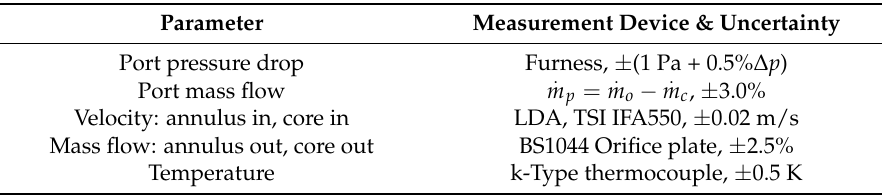
Table 1. Measurement uncertainty of key